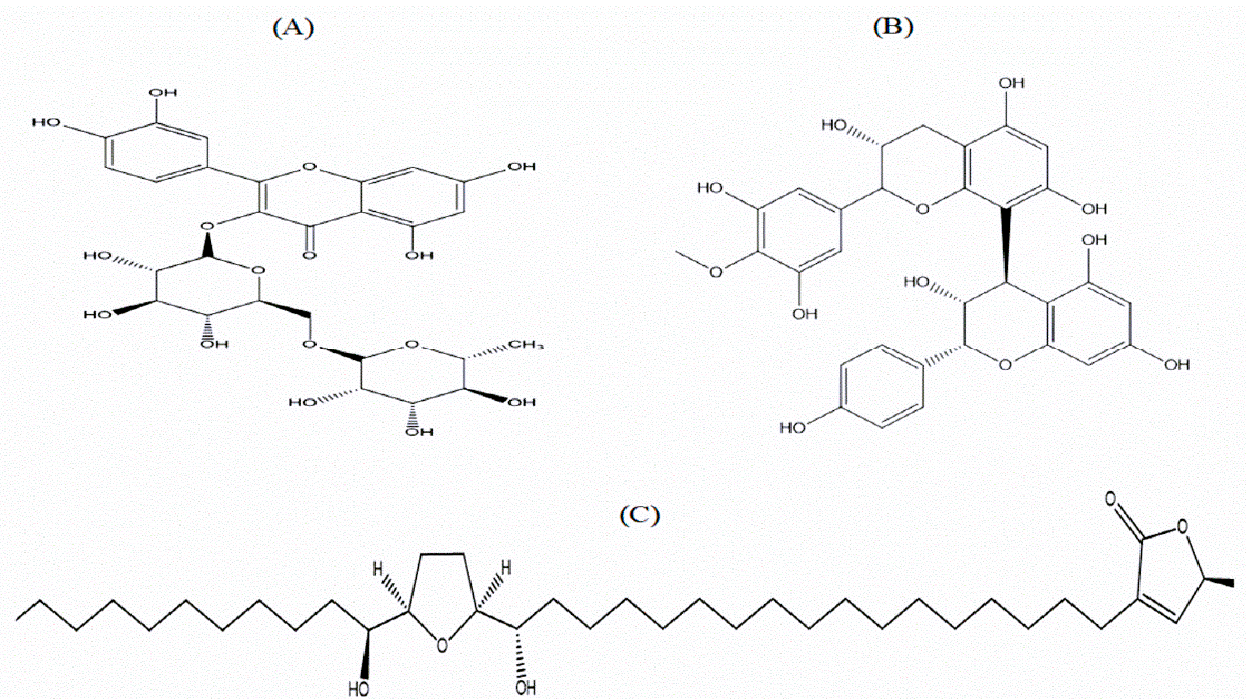
Figure 7. Chemical structure of putative phytomolecules derived from the EEAS. ( A ) Rutin, ( B ) proan-